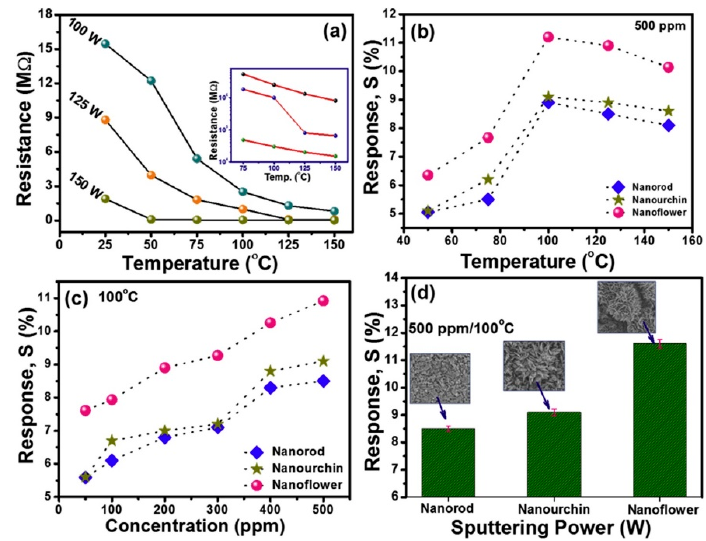
Figure 3. (a) Resistance versus temperature for V 2 O 5 prepared under different sputtering powers ( b ) response of different morphologies of V 2 O 5 as a function of temperature ( c ) response of different V 2 O 5 nanostructures versus CH 4 concentrations at 100 °C. ( d ) Comparison between the response to 500 ppm CH 4 of different morphologies of V 2 O 5 at 100 °C [52].